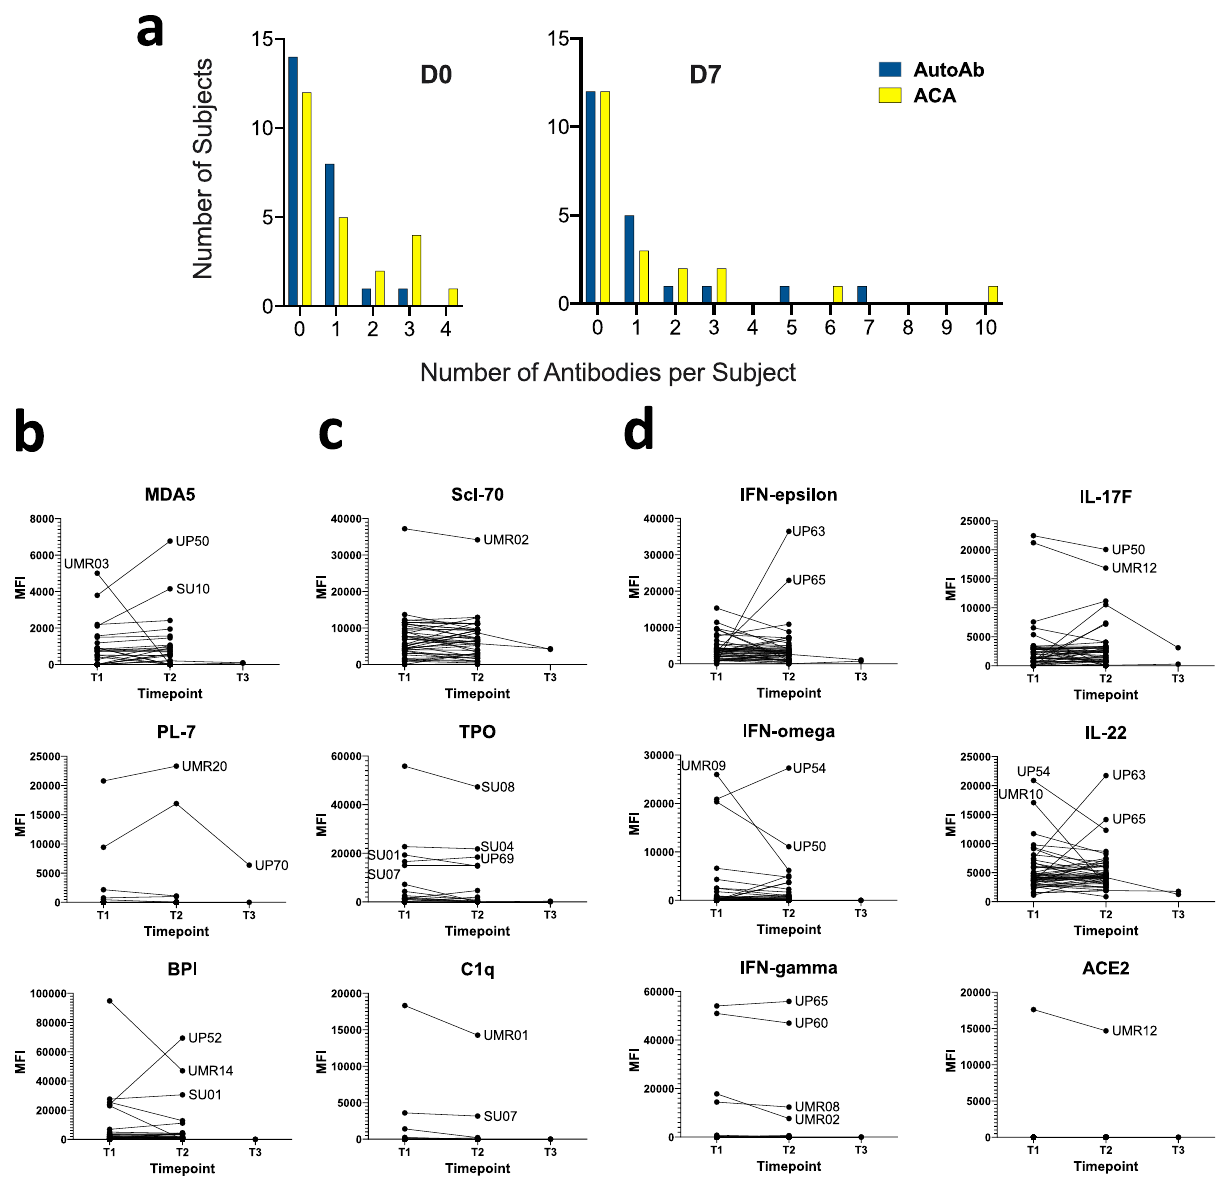
Fig. 3 Autoantibodies are triggered by SARS-CoV-2 infection. a Autoantibody (AutoAb, blue) and anti-cytokine antibody (ACA, yellow) counts are shown at Day 0 ( n = 24 patients, left) and Day 7 ( n = 21 patients, right). Counts were based on antibodies that were present at levels at or exceeding 5 SD above the average MFI for healthy control samples. b Examples of transient or fl uctuating autoantibodies against MDA5, the tRNA synthetase PL-7, and the vasculitis antigen BPI are shown. c Examples of antigens (Scl-70, TPO, and C1q) that are likely to have been present at the time of infection and are unaffected by SARS-CoV-2 infection, are shown. d Examples of ACA that are inducible (e.g., IFN- ε ), fl uctuate (e.g., IFN- ω ), or are present at baseline with little change over time (e.g., IFN- γ ), are shown. Additional examples (IL-17, IL-22, and ACE-2) are also included. MFI is shown on the y -axis. Serum was collected at three time points (T1, T2, and T3) for two COVID-19 subjects, while serum was collected at two time points (T1 and T2) for all other COVID-19 subjects. COVID-19 subjects with notably high MFI at any time point are labeled. Source data are provided as a Source Data fi